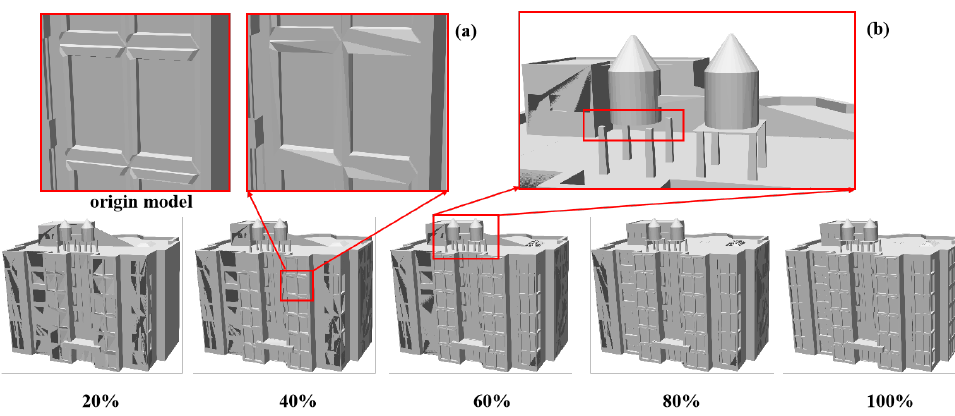
Figure 1. Performance of the building under the transmission of different amounts of data, using the edge as the encoding unit. ( a ) geometric constraint is broken. ( b ) topological constraint is bro-